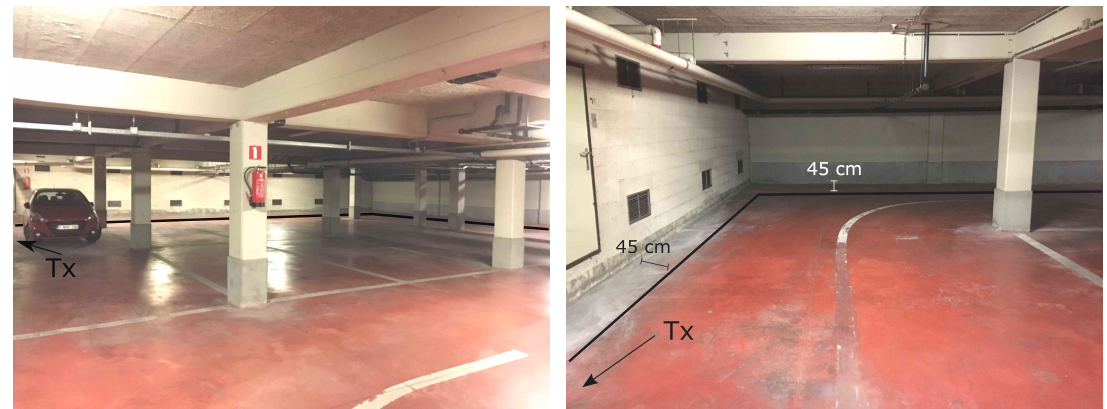
Figure 4. Scenario WIC: View showing the wall and the corner where the measurement takes place ( left ) and a close-up ( right ). The measurement path is indicated by the black line, the location of the Tx is pointed to by the arrow. The underground parking garage was almost completely empty at this time.